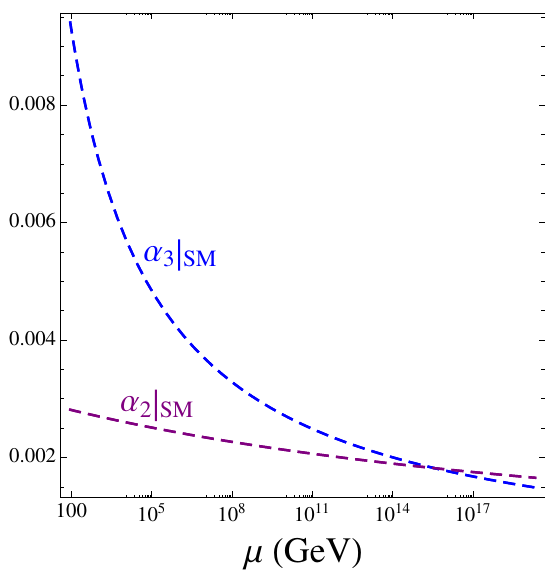
Figure 5 . SM running of the strong and weak gauge coupling (cid:11) 3 (blue) and (cid:11) 2 (purple) from the Z mass up to Planckian energies. The SM GUT scale reads approximately (cid:22) GUT (cid:25) 4 (cid:2) 10 15 GeV. UV safe trajectories have to coincide with SM values at the matching scale (cid:22) = M where BSM matter